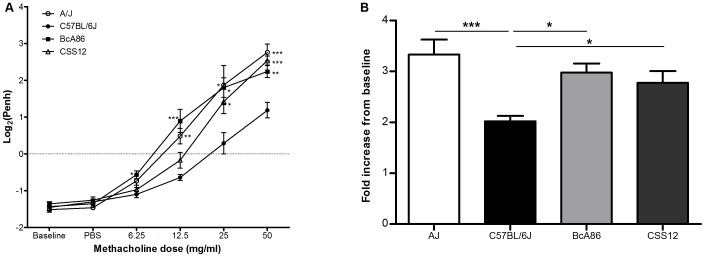
Genetic background of mouse Chromosome 12 determines airway responsiveness phenotype.(A) Log2(Penh) response curve to increasing doses of methacholine in A/J, C57BL/6J, BcA86, and CSS12 strains. The asterisks label the strains which are significantly different from C57BL/6J at each respective dose. (B) The airway resistance of A/J, C57BL/6J, BcA86 and CSS12 mice to 25 mg/ml of methacholine was measured by the gold standard invasive plethysmography and normalized to baseline readings. Data are presented as mean ± SEM and statistical significance was calculated by one-way ANOVA and Bonferroni correction. n>5 mice per strain for both experiments; *, **, and *** represent p<0.05, p<0.01 and p<0.001, respectively.